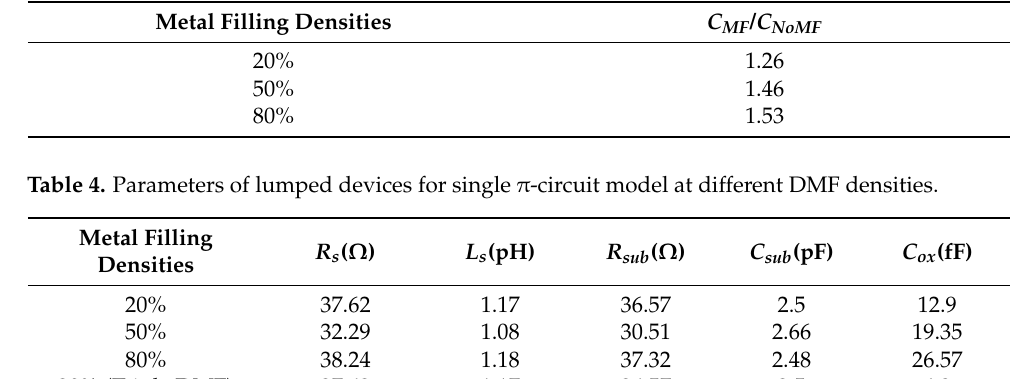
Table 3. The ratio of capacitance before and after metal filling for different metal filling densities.